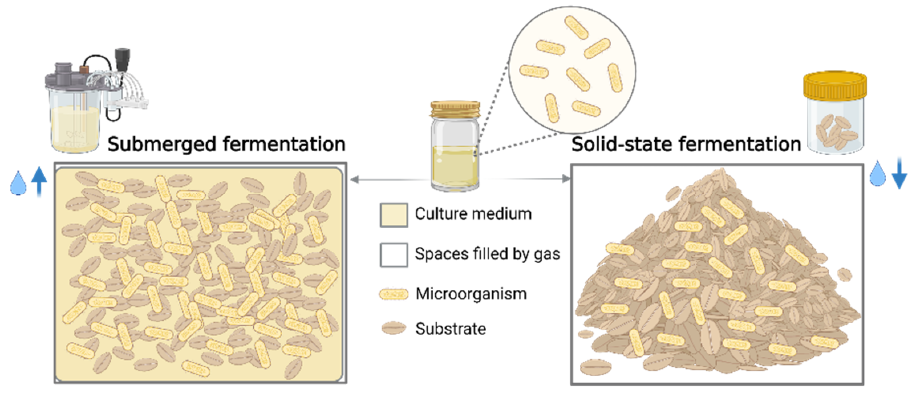
Figure 4 . Solid-state fermentation and submerged fermentation . Figure 4. Solid-state fermentation and submerged